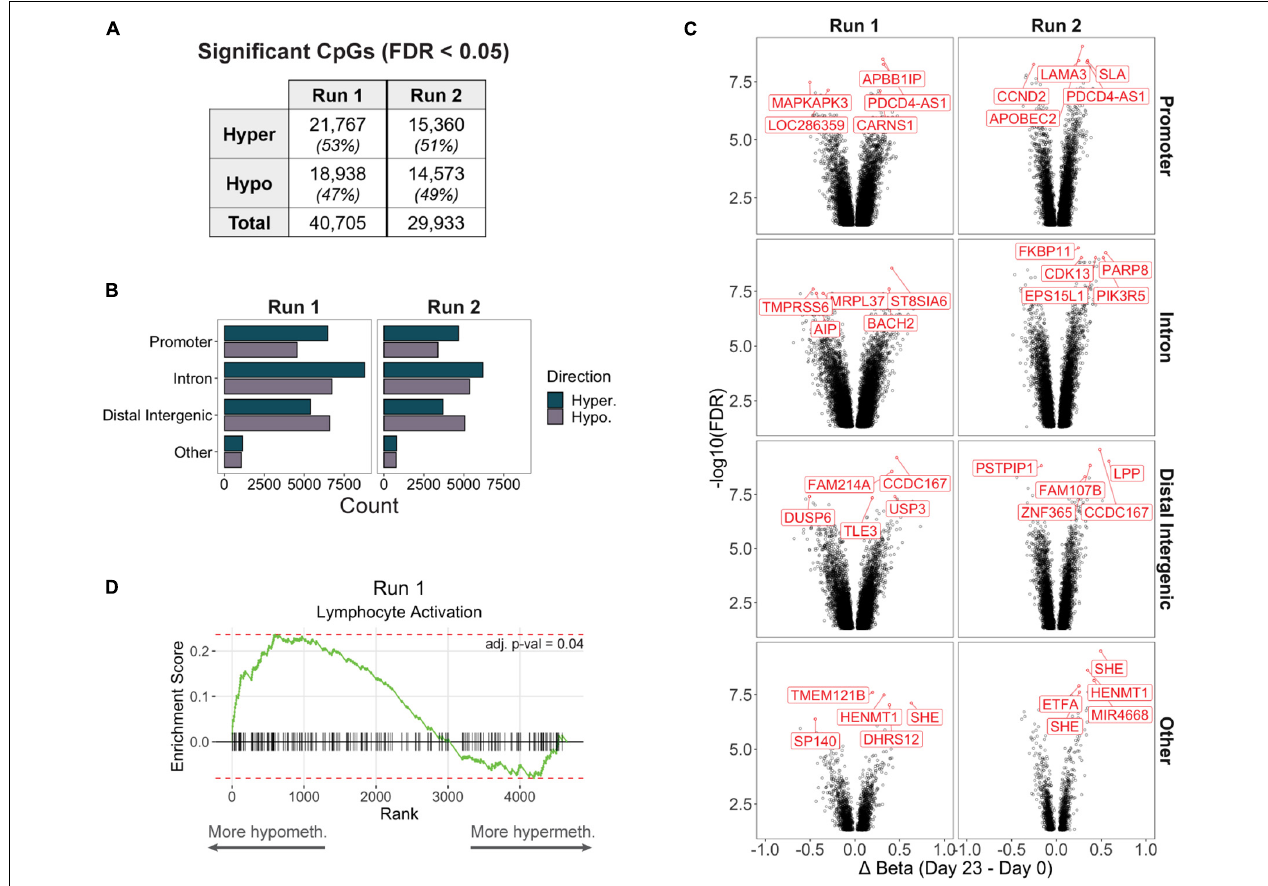
FIGURE 2 | (A) Significantly differentially methylated CpGs (differentially methylated positions, DMPs) between day 0 and day 23 products in each production run. (B) Counts of hyper- or hypomethylated DMPs mapping to the promoter, intron, distal intergenic, or other (5 (cid:48) or 3 (cid:48) UTRs, exons, or immediate downstream) region of a gene. (C) Volcano plots of significant DMPs (FDR < 0.05) stratified by genic annotation. The top 5 most significant DMPs (stratified by genic annotation) are highlighted. (D) In Run 1, genes that contained at least 1 promoter DMP but did not contain any differentially methylated regions (DMRs, including at least 3 CpGs) were significantly enriched for the Lymphocyte Activation pathway (adj. p -val <